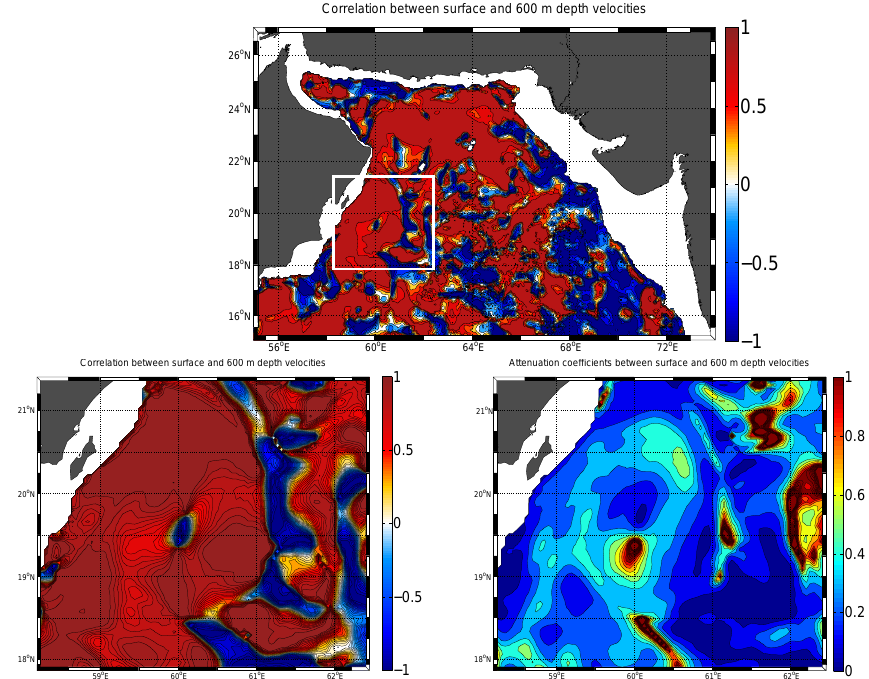
Figure 10. Maps from HYCOM: (top) correlation coefficient between surface and 600m depth velocities; (bottom, left) zoom on a mesoscale eddy; (bottom, right) attenuation coefficient between the surface and 600m depth velocities: up to 50% of the intensity is observed.